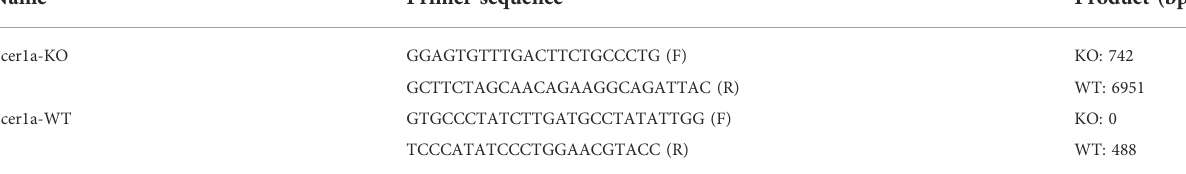
TABLE 3 Primer sequence information on Fcer1a KO and WT